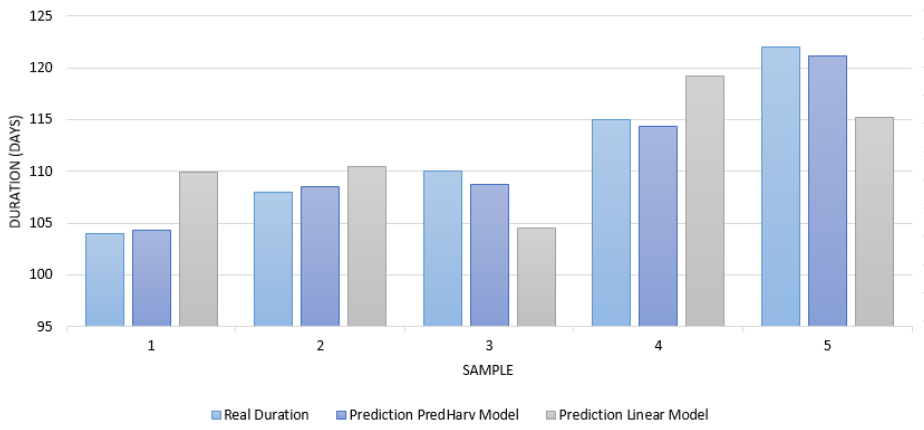
Figure 9. PredHarv model and linear model prediction results—DS1